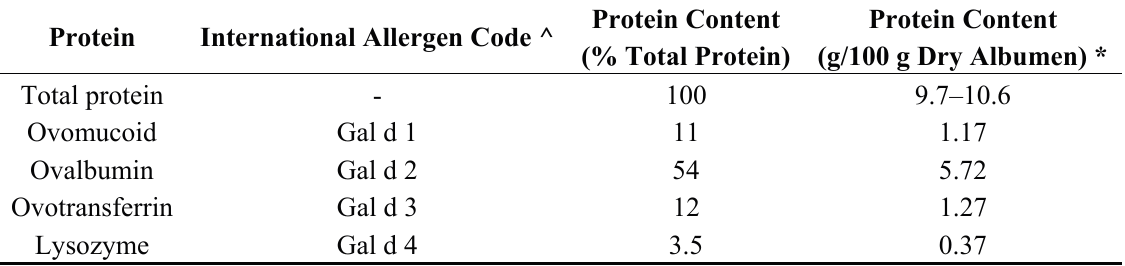
Table 1. Main allergens of egg white